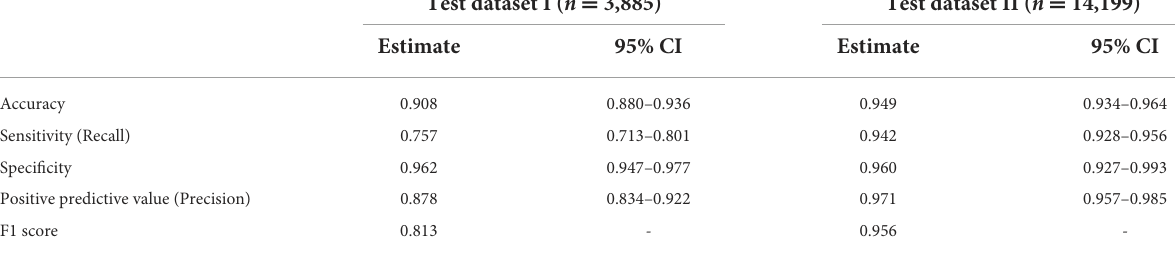
TABLE 2 The performance of AI for recommendation pupil dilation test in test dataset I and II.